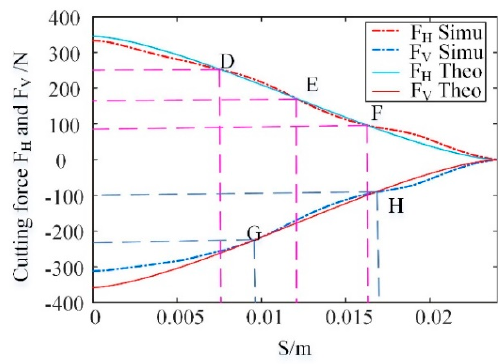
Figure 17. Analytical and simulation results of the cutting forces F H and F V.